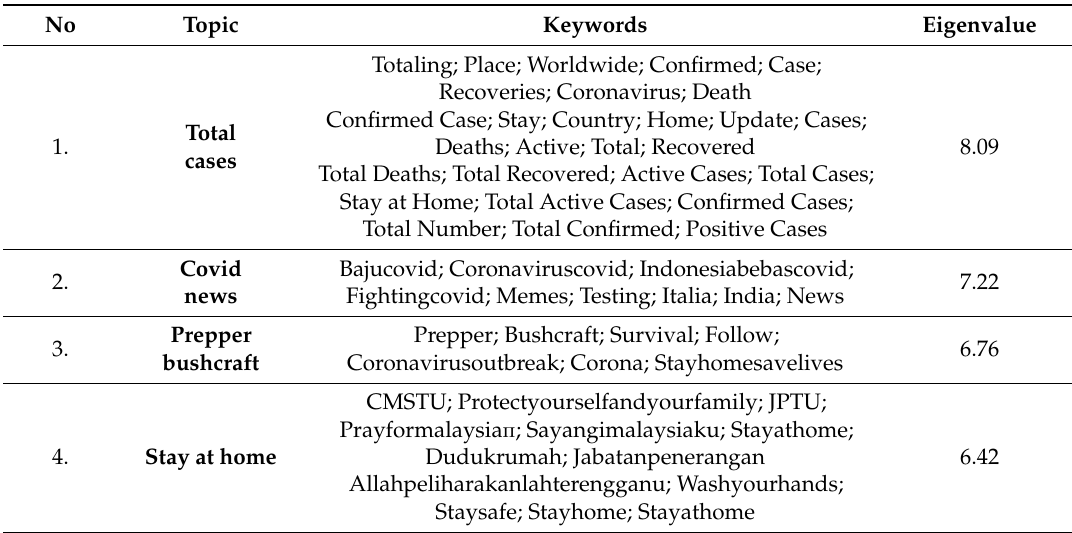
Table 1. Topic modelling of Twitter bots’